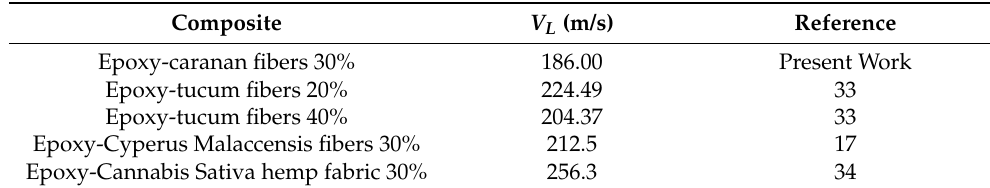
Table 6. Limit velocity for 30 vol% epoxy-caranan and other NLF-reinforced composites in the literature.